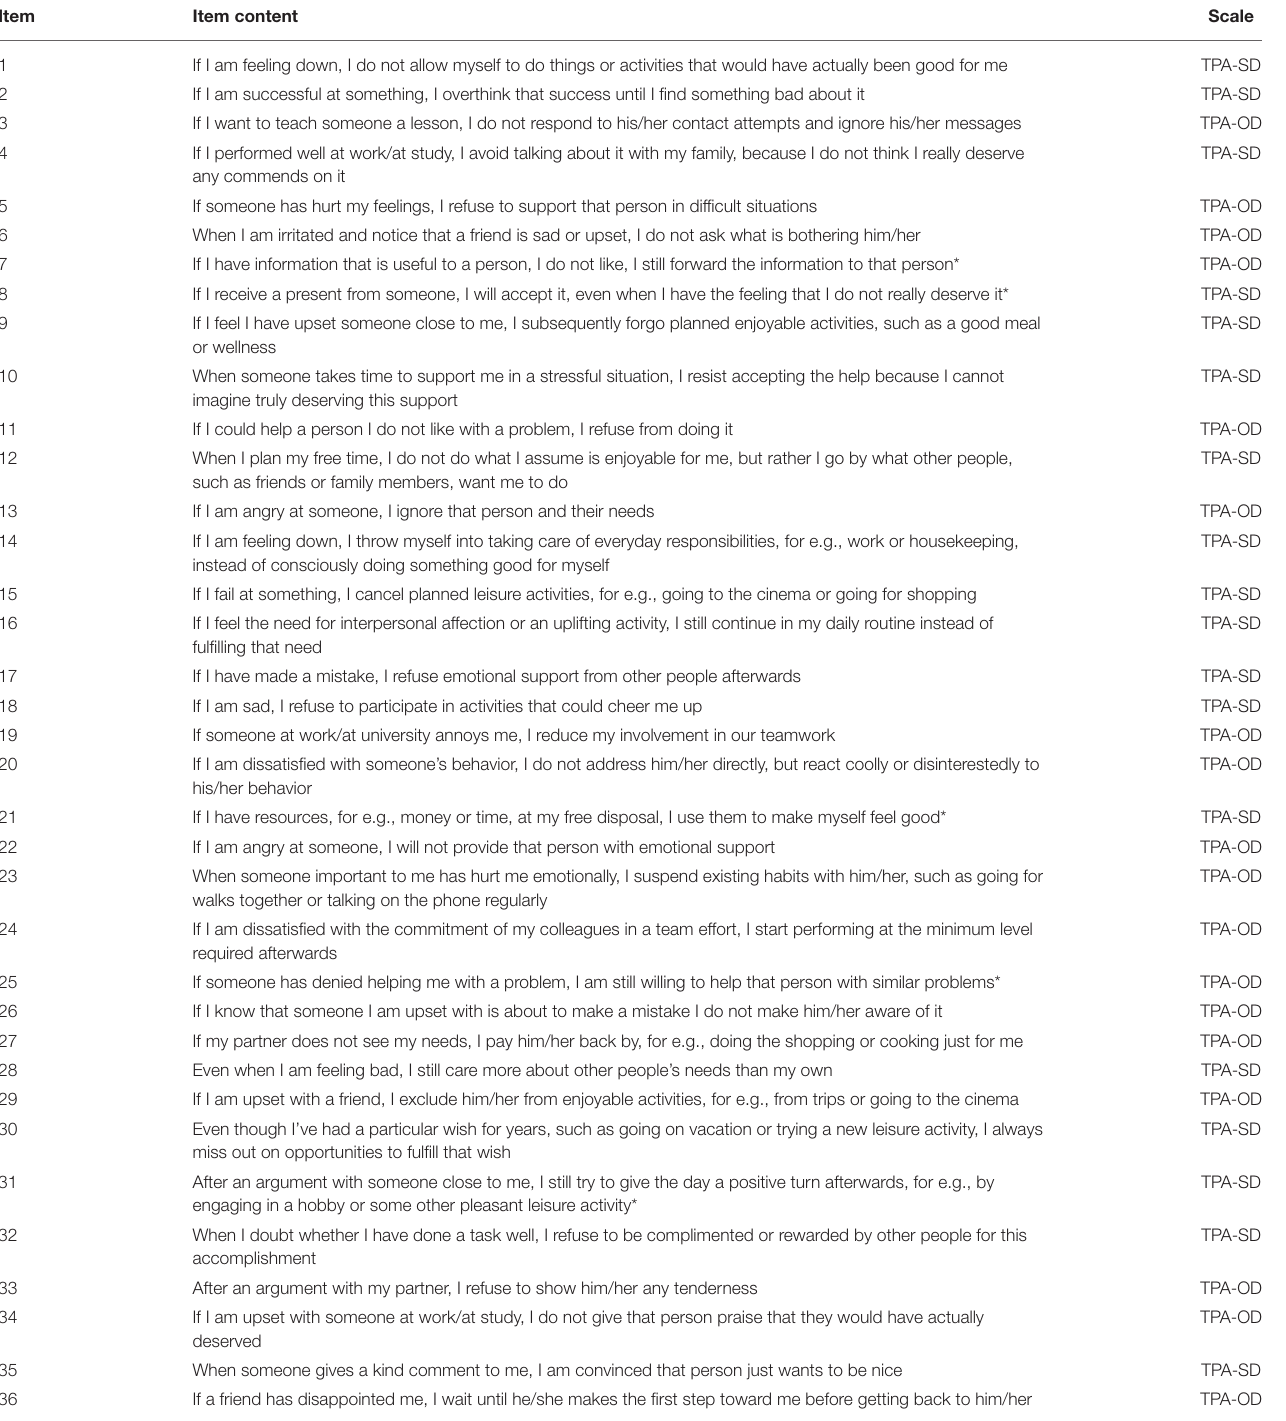
TABLE 1 | Items of the 36-item version of the